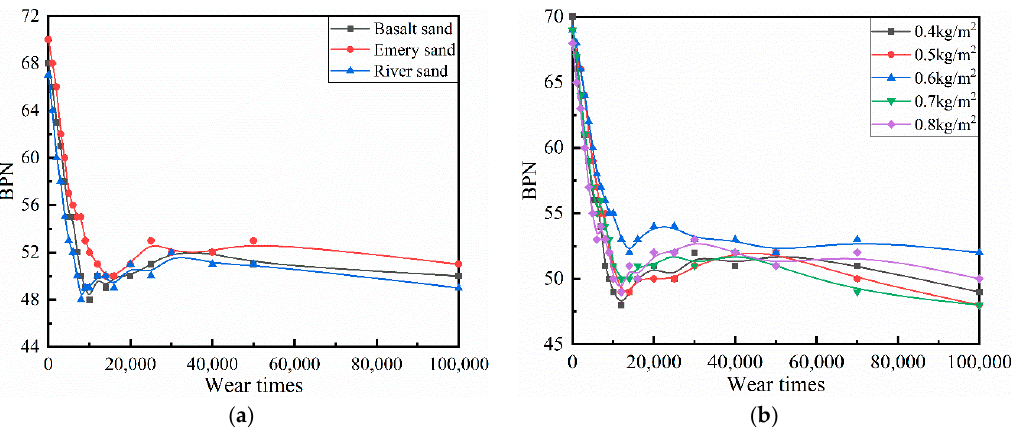
Figure 16. Test results of skid resistance fog seal development: ( a ) skid resistance particle type; ( b ) skid resistance particle dosage.